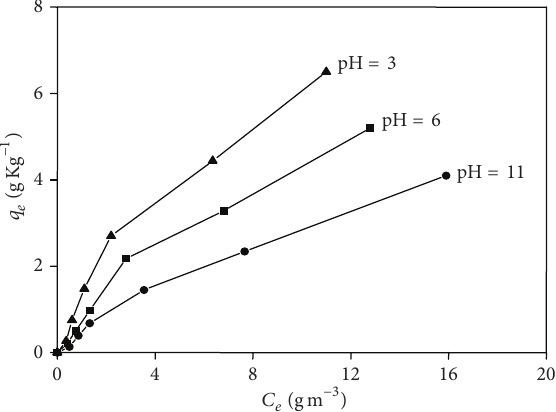
F 4: Equilibrium adsorption of reactive dye on